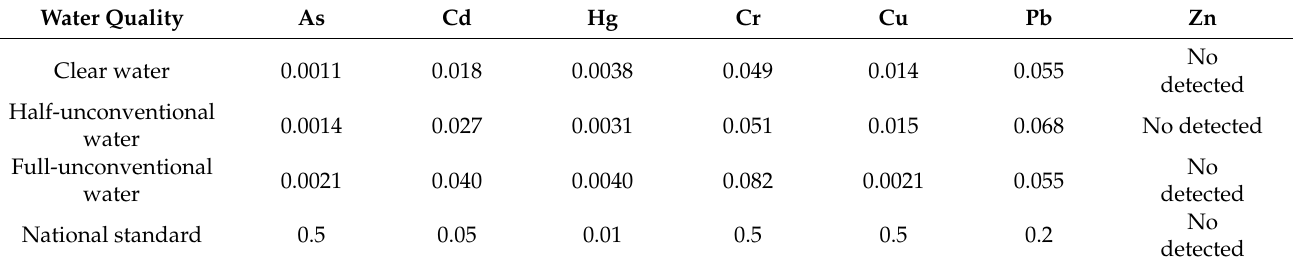
Table 4. Cucumber fruits heavy metals contents in condition of different irrigation water quality.